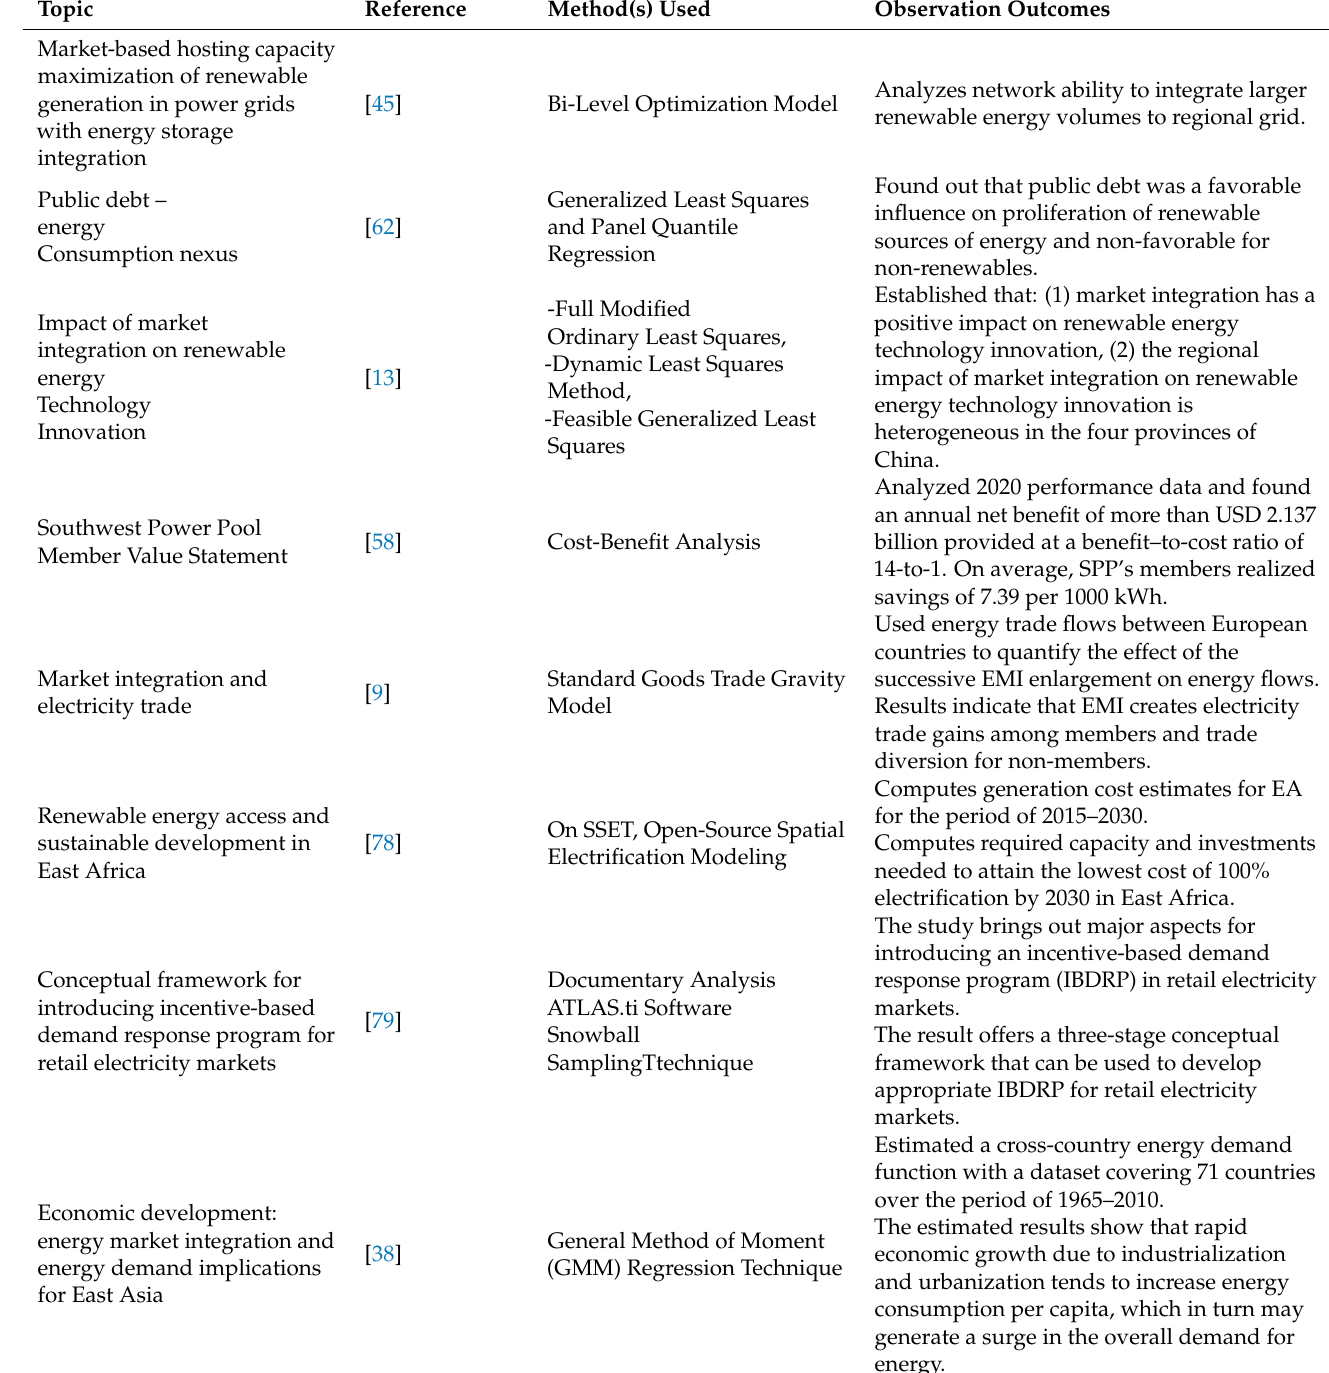
Table 12. A short review of the methods used in studies on power pool